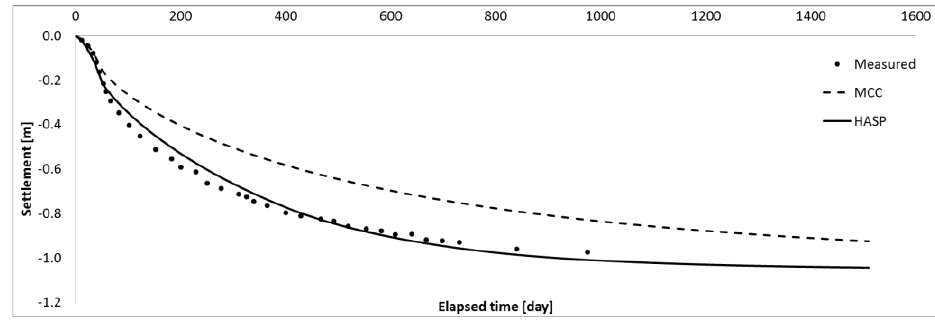
Figure 9. Comparison of settlement-time curves for Embankment A — Point 𝑆 1 (2.8 m below sur-